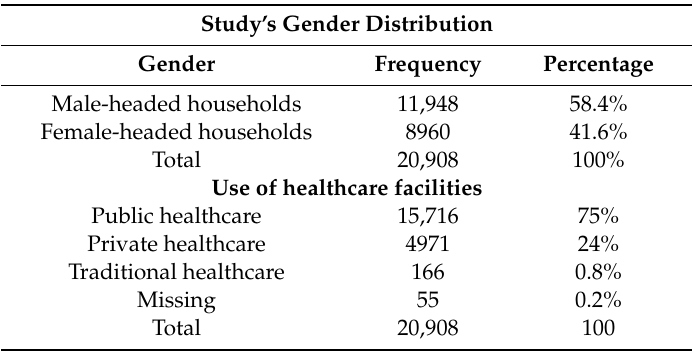
Table 3. Study’s gender distribution and use of healthcare